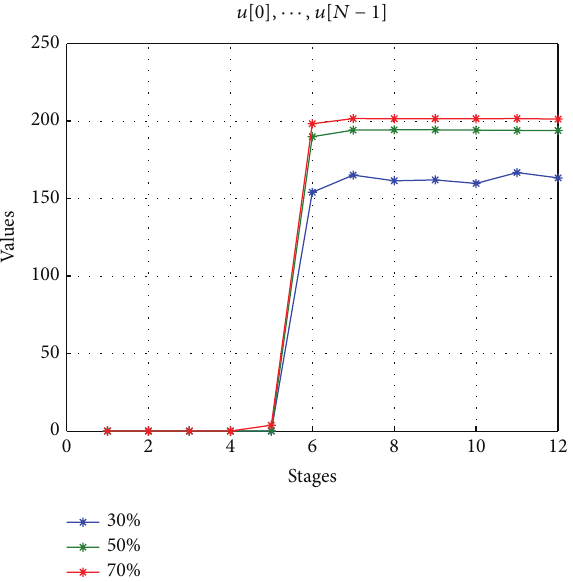
Figure 7: Case 2, band of values for optimal orders.